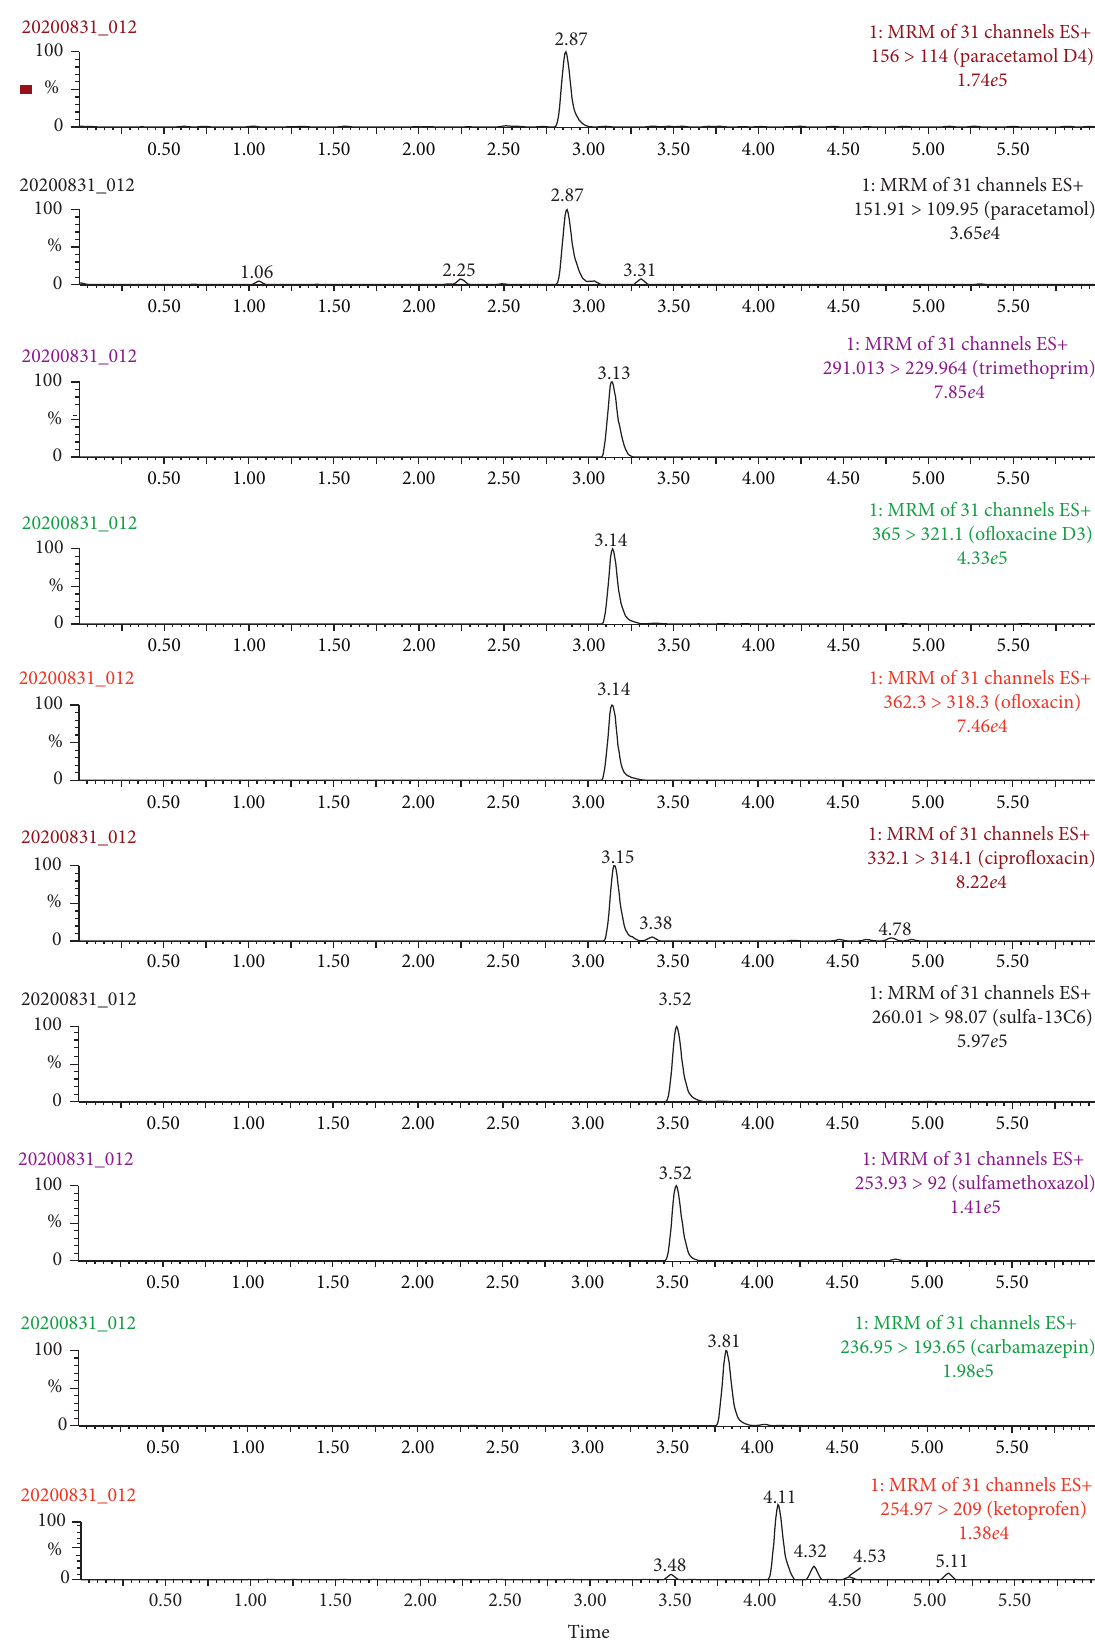
Figure 2: Extracted ion chromatograms of all standard compounds at 100 µ g L − 1 except IS at 50 µ g L − 1